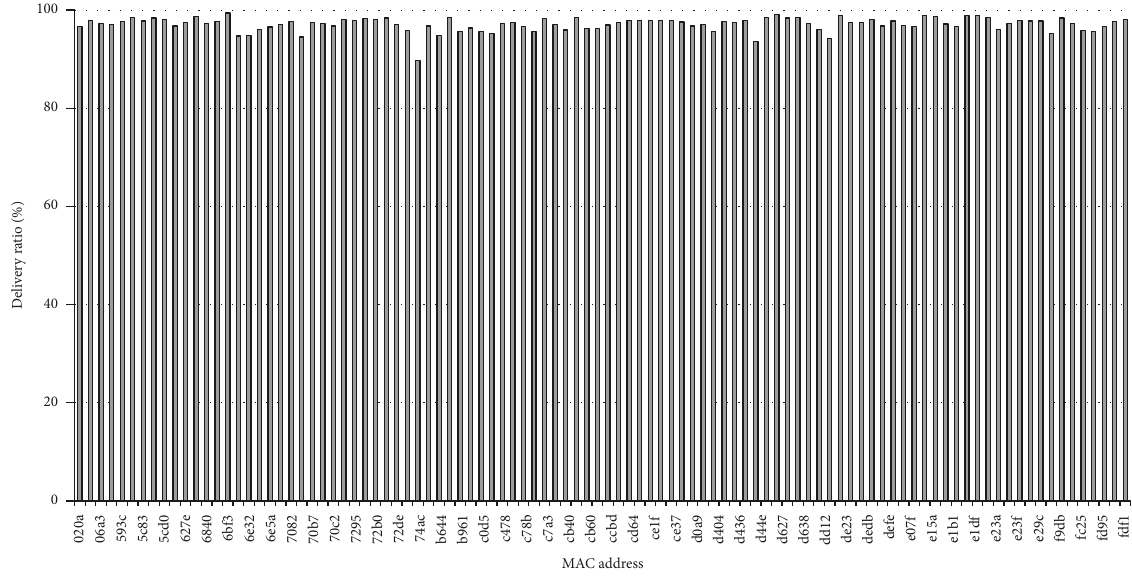
Figure 19: Delivery ratio performance with 100-node